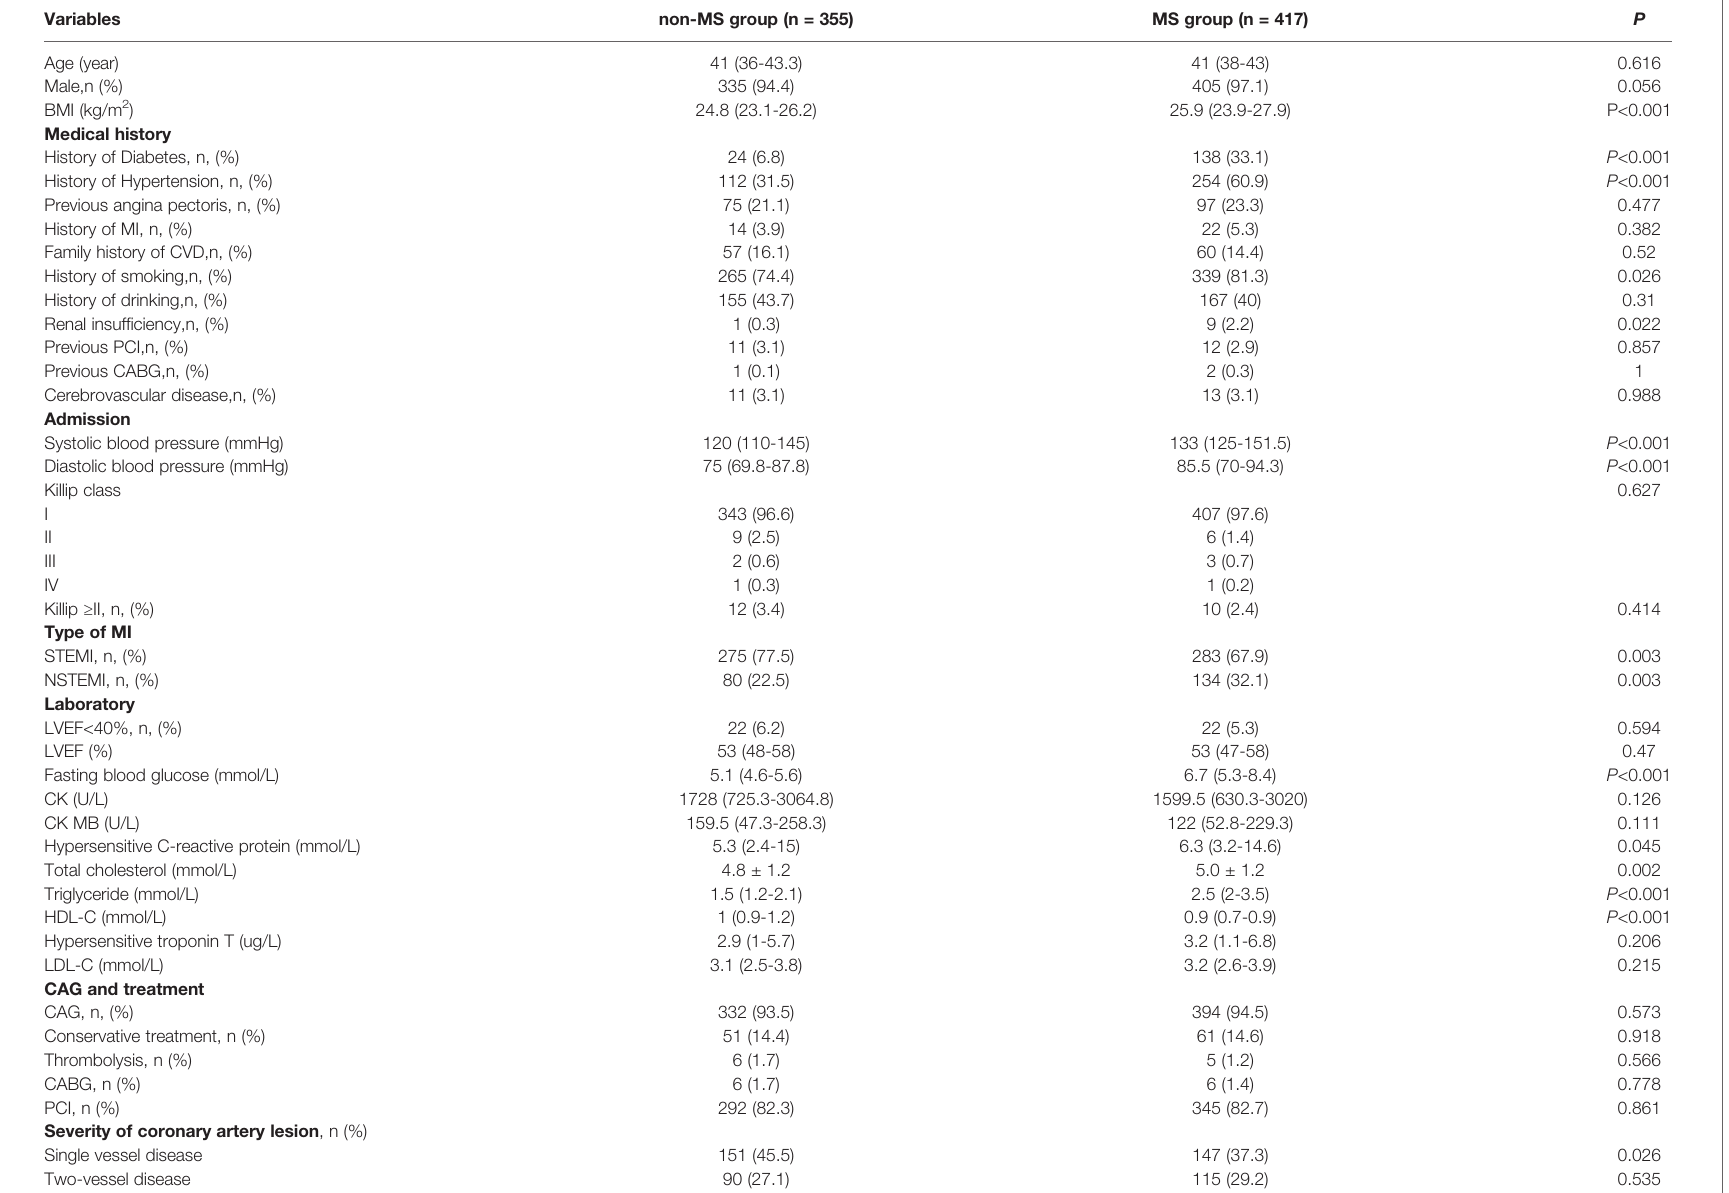
TABLE 1 | Demographic and clinical characteristics of patients with premature myocardial